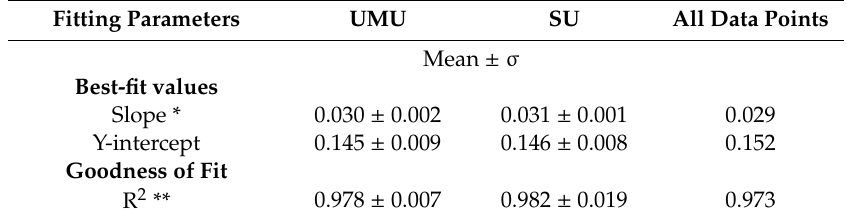
Figure 4. ( a ) Absorbance spectra of SFN with increasing quantities of NAR; ( b ) Six calibration data sets and their respective calibration lines, three obtained at the University of Murcia (UMU) and three at Stockholm University (SU). ( c ) Calibration data set including all data points. Table 1. Calibration curve parameters. The first two columns list the average parameters and standard deviation ( σ ) for each set of three calibration lines obtained at the University of Murcia (UMU) and Stockholm University (SU). The third column lists the parameters of the calibration line fitted to all data points under the constraint of passing through the average value at 0 NAR%